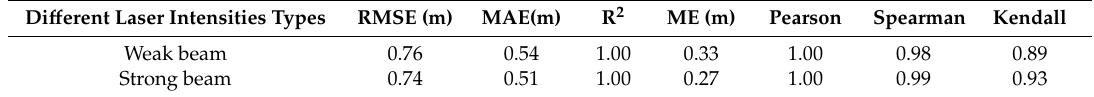
Table 5. Statistical indicators for di ff erent laser